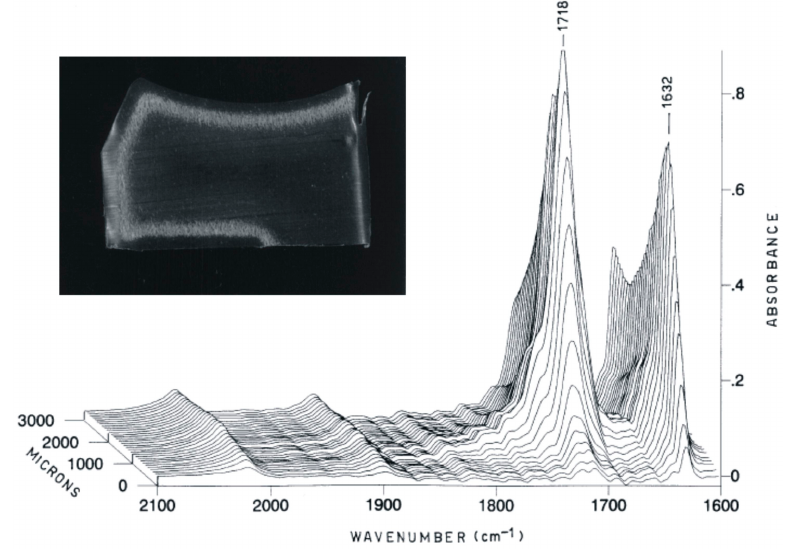
Figure 1. Cross-section of a gamma-air sterilized tibial insert, exhibiting a characteristic “crown-effect” (subsurface white band), along with its Fourier Transform InfraRed (FTIR) spectra, showing the presence of abundant oxidation products. Adapted from [17], with permission.